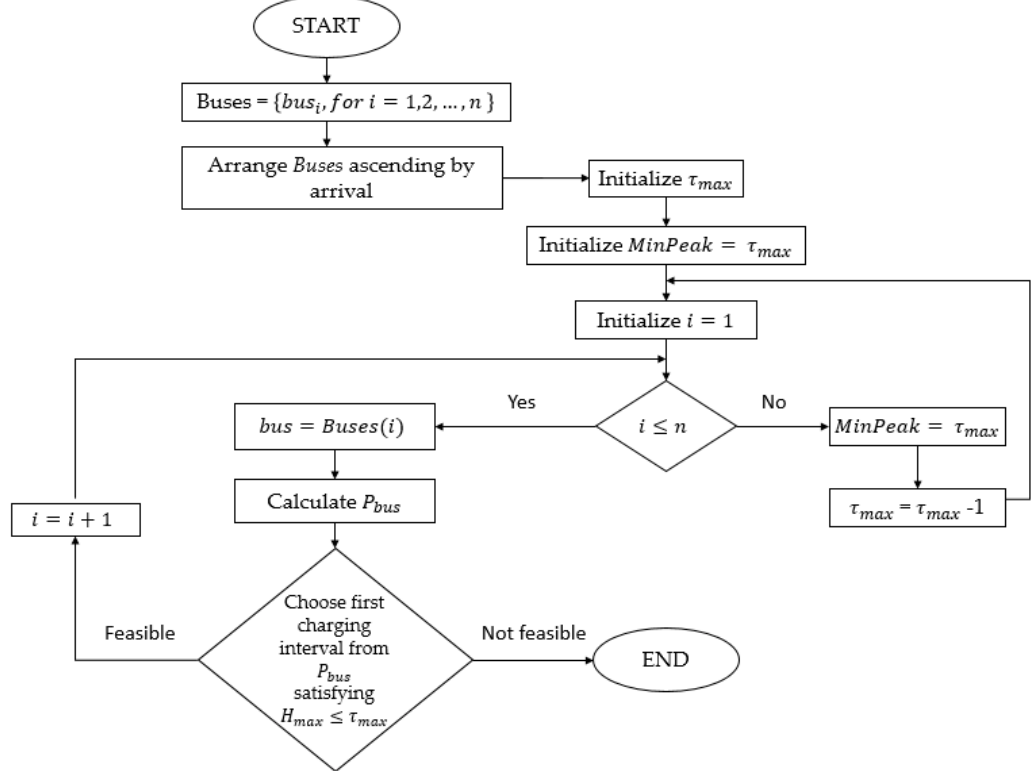
Figure 6. Greedy algorithm presented with a flowchart.